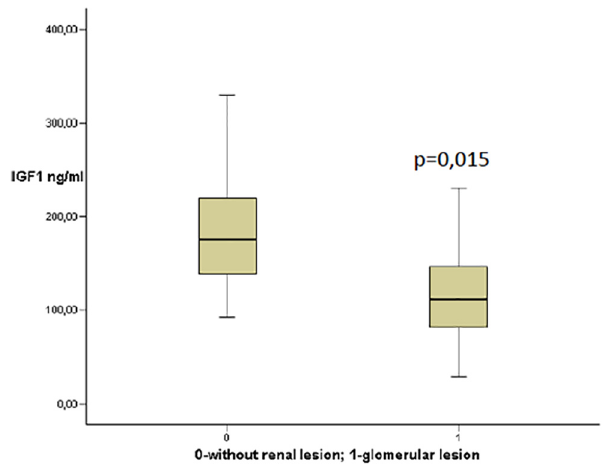
Fig 1. IGF-1 levels in patients with and without renal lesion. IGF-1 levels and IGF-1 SDS in patients without renal lesions were significantly different from patients (with n > 10) with different types of obesity related glomerular